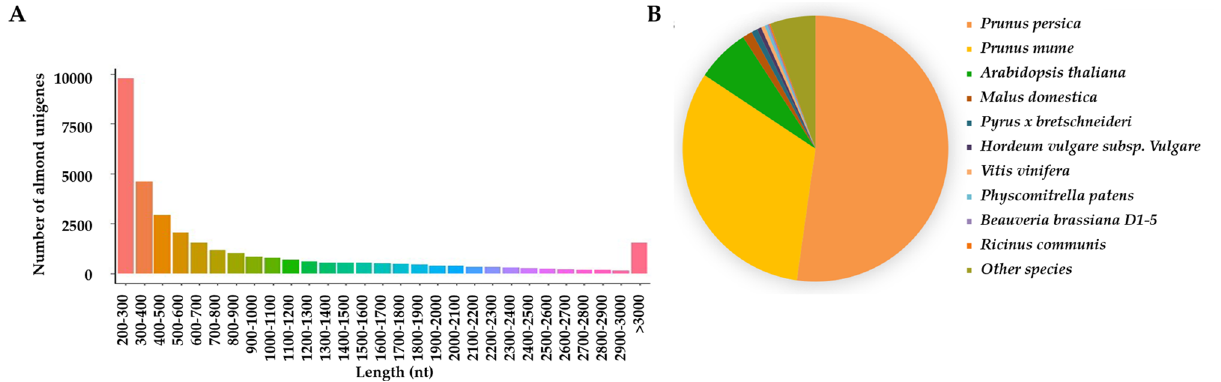
Figure 2. ( A ) Length distribution of almond representative unigenes; ( B ) Pie chart of almond unigene